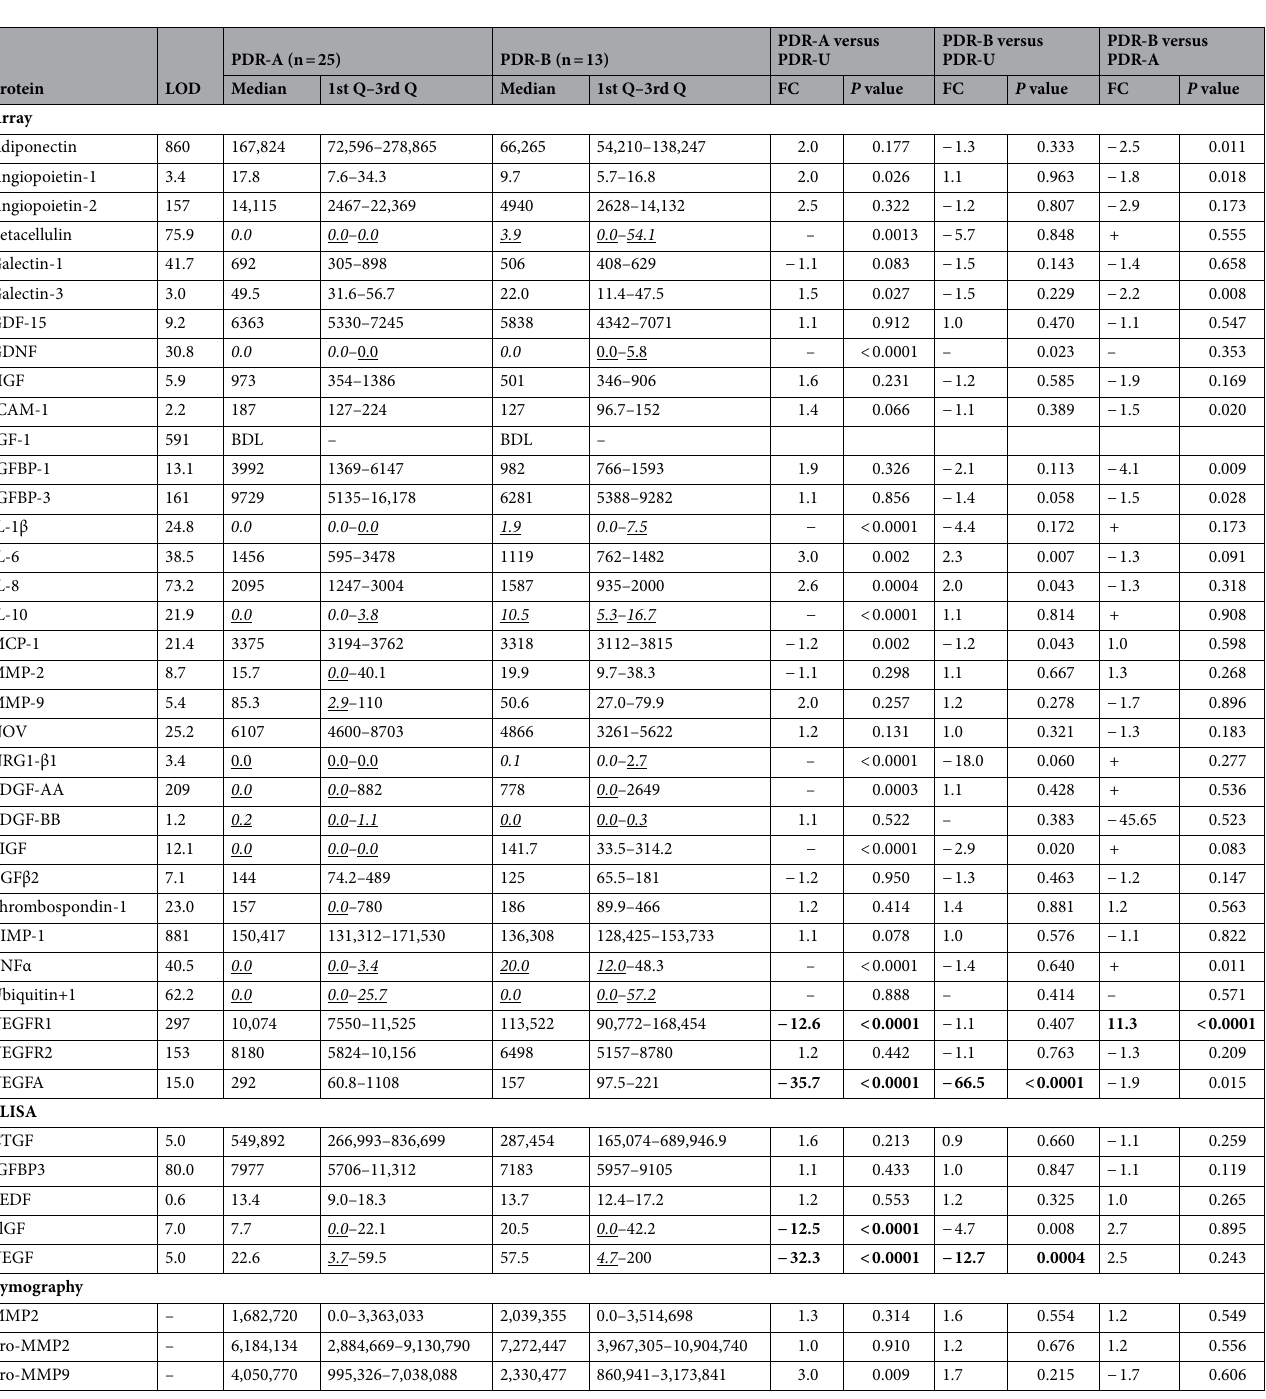
Table 5. Protein concentrations in vitreous of PDR patients that were pre-operatively treated with anti- VEGF. PEDF data is presented in µg/ml, Zymography data is expressed as intensity of bands in arbitrary units. All other protein data are presented in median pg/mL with 1st and 3rd quartile values. BDL, below limit of detection (LOD); FC, fold change; PDR-A, PDR patients treated with aflibercept; PDR-B, PDR patients treated with bevacizumab or ranubizumab. Values that are based on protein levels that are lower than LOD are underlined and indicated in italics, and should be considered less reliable. Fold changes with ’+’ or ’-’ present higher(+) or lower(-) protein levels which could not be determined because of zero median levels in one or more groups. The Mann-Whitney U test was used to assess statistical differences between both treatment groups. Fold changes higher than 5-fold and significant differences (P < 0.001) are indicated in